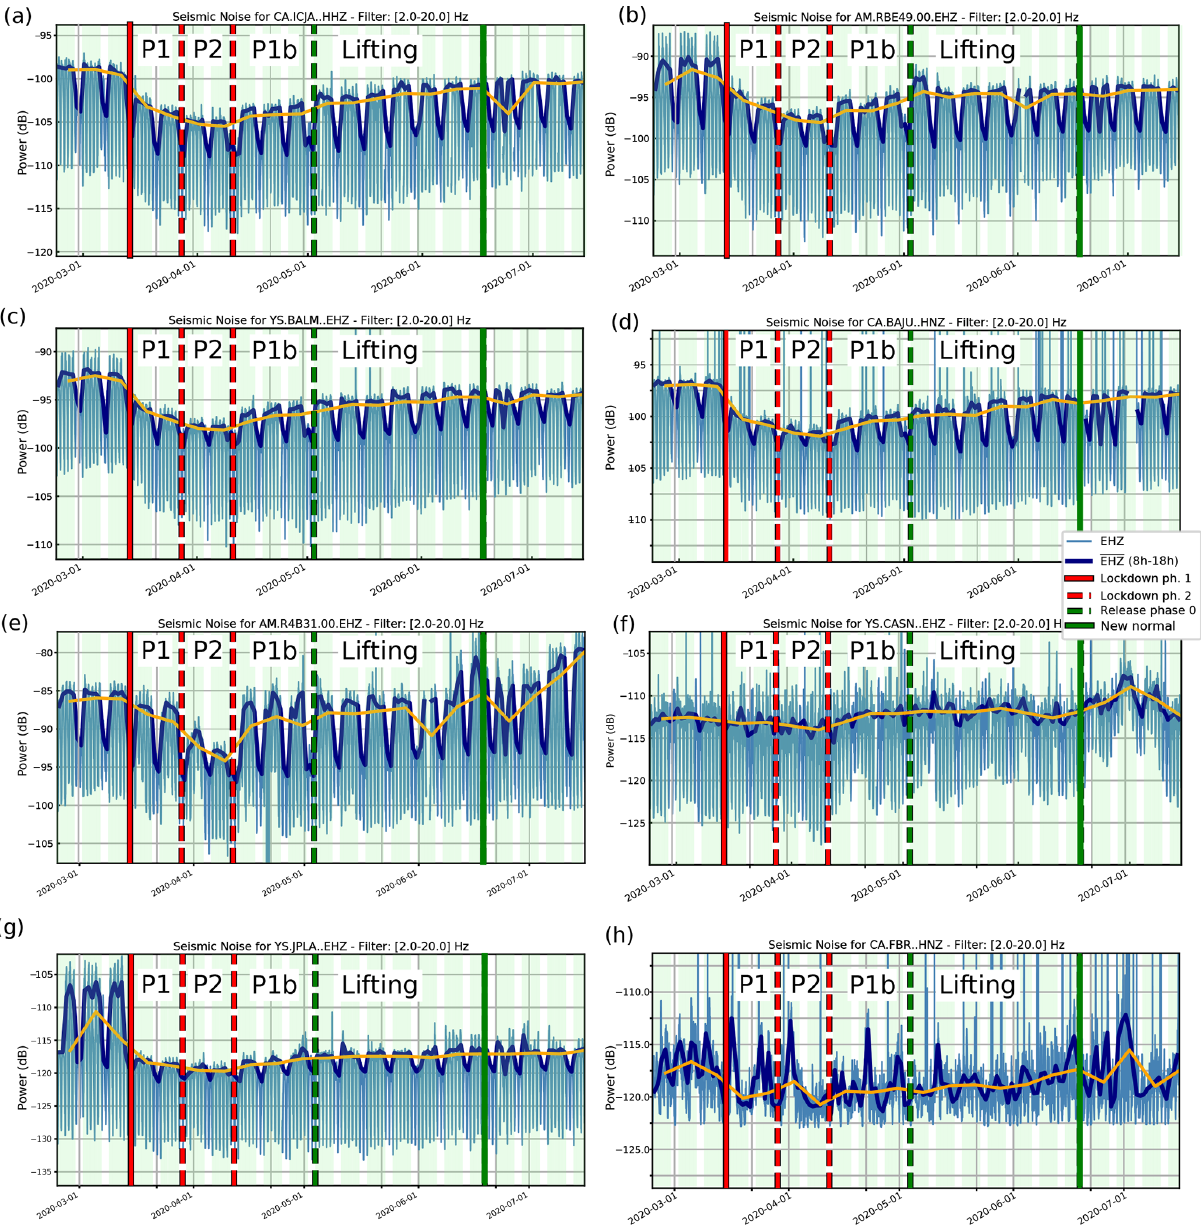
Figure 7. Variations in the PSD of the seismic acceleration in the 2–20Hz band for representative stations. (a–d) Sites that follow the general trend. (e–h) Sites with particular characteristics (see text). Light blue line: data every 15min. Dark blue line: daily mean value during business hours (09:00–19:00). Orange line: weekly mean average during working